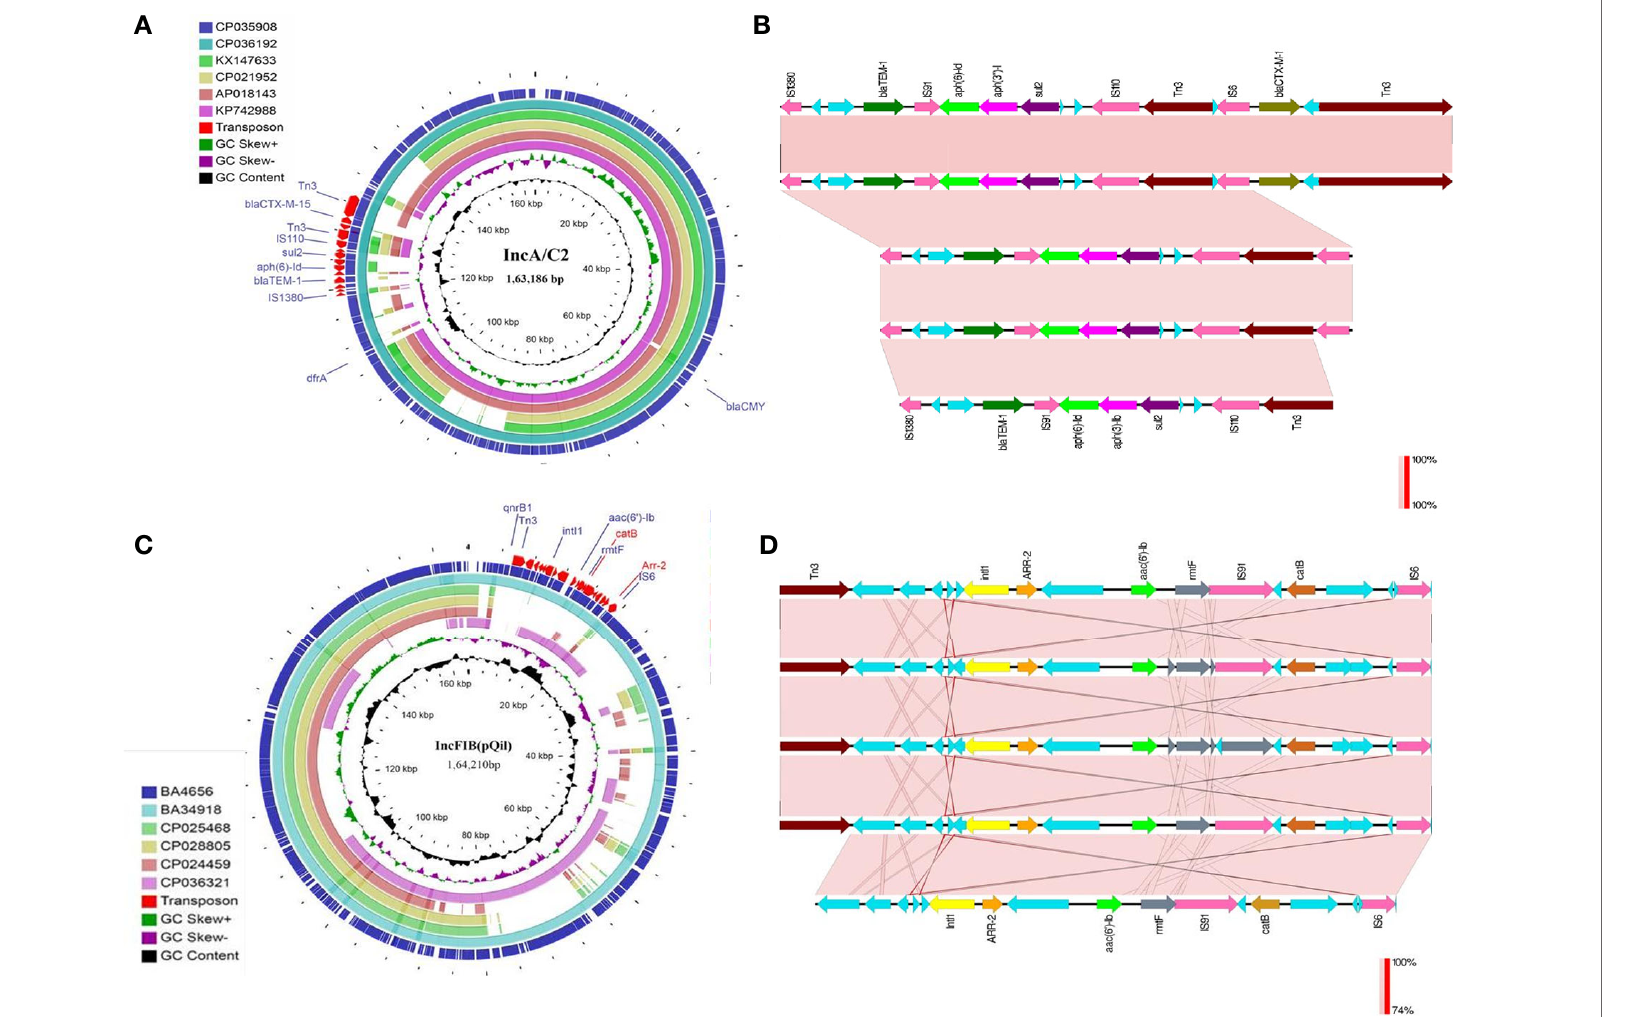
FIGURE 3 | (A) The structures of the IncA/C 2 plasmids identi fi ed in the present study (CP035908, 163,186bp and CP036192, 165,052bp). Sequence comparison with other IncA/C 2 plasmids showed that the plasmid displayed 99% conservation with IncA/C 2 plasmids from Klebsiella pneumoniae AR_0148 (CP021952), Citrobacter freundii (KX147633), Escherichia coli (AP018143), and Salmonella Senftenberg (KP742988). Tn6691 on IncA/C 2 carried bla TEM-1B , bla CTX-M-15 , aph(6)-ld and aph(3 ’’ )-lb . (B) Comparison of the Tn6691 elements on IncA/C 2 among B4656 (CP035908) and BA34918 (CP036192) with E. coli strain 109 (CP020523), K. pneumoniae strain INF249 (CP024489), and Salmonella enterica subsp. enterica serovar Typhimurium strain UGA14 (CP021463) in the above-mentioned order. (C) The structures of the IncFIB (pQil) plasmids identi fi ed in the present study (CP035907, 164,210bp and CP036194, 108,957bp). Tn 6692 present on IncFIB(pQil) carried ARR-2 , catB , rmtF , and aac(6 ’ )-lb3 . (D) Comparison of the transposon Tn 6692 on IncFIB in the following order: K. pneumoniae strains AR0138 (CP021758), BA4656 (CP035907), BA34918 (CP036193), KPN1482 (CP020842), and SKGH01